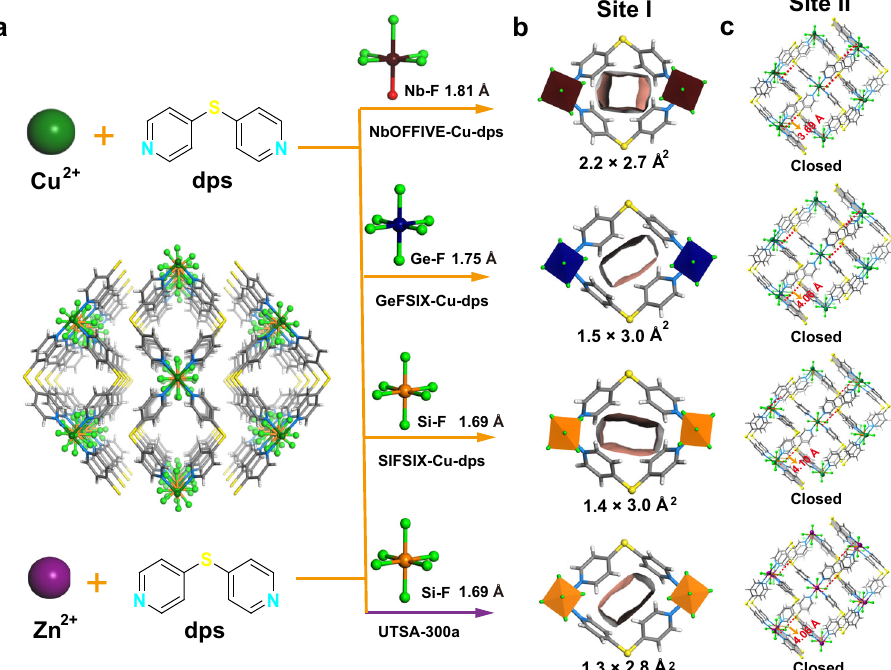
Fig. 1 Crystallographic structures. a Synthesis procedure of three isoreticular MOFs. Views of b Site I and c Site II in activated NbOFFIVE-dps-Cu, GeFSIX- dps-Cu, SIFSIX-dps-Cu, and UTSA-300a with varying pore aperture size. Color code: Cu, green; F, light green; S, bright yellow; N, light blue; C, gray; Si, orange; Ge, navy blue; Nb, wine red; and solvent molecules are omitted for